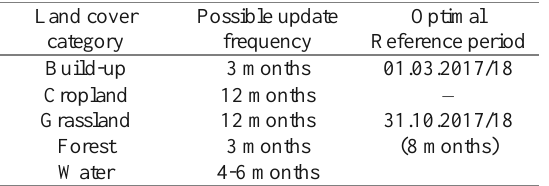
Table 1 . Recommended update frequency by land cover type.